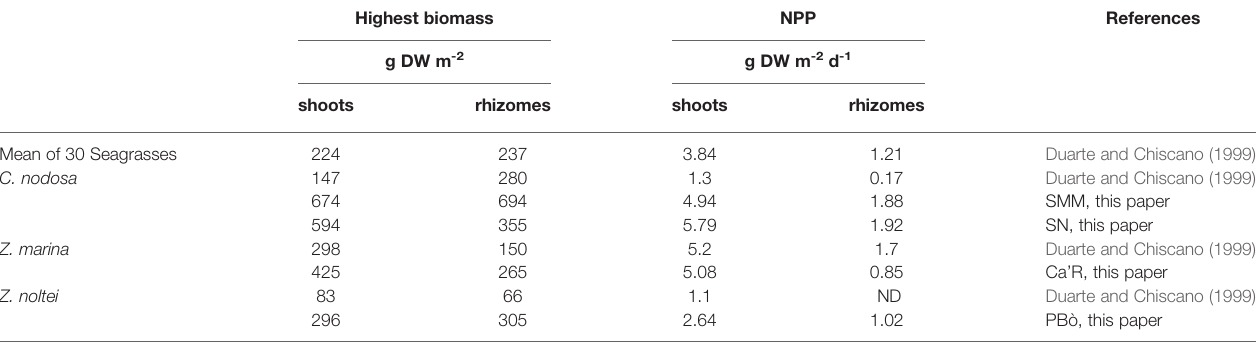
TABLE 5 | Comparison of angiosperm biomass and Net Primary Production